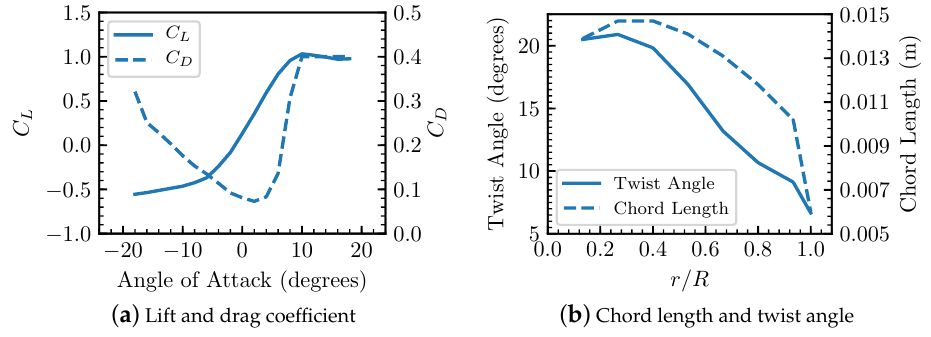
Figure 4. Turbine parameterizations for rotor GWS/EP-6030